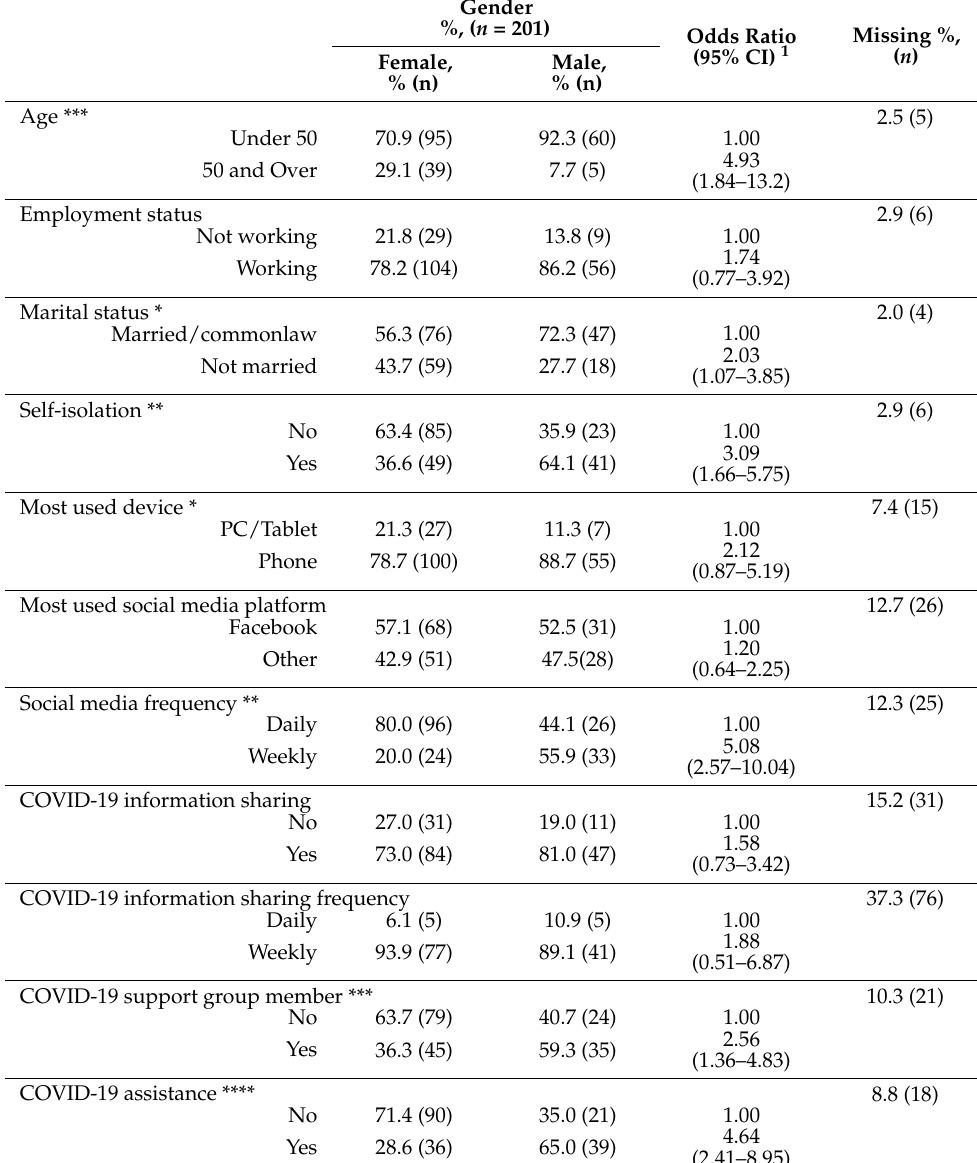
Table 3. Key variables stratified by gender ( n =